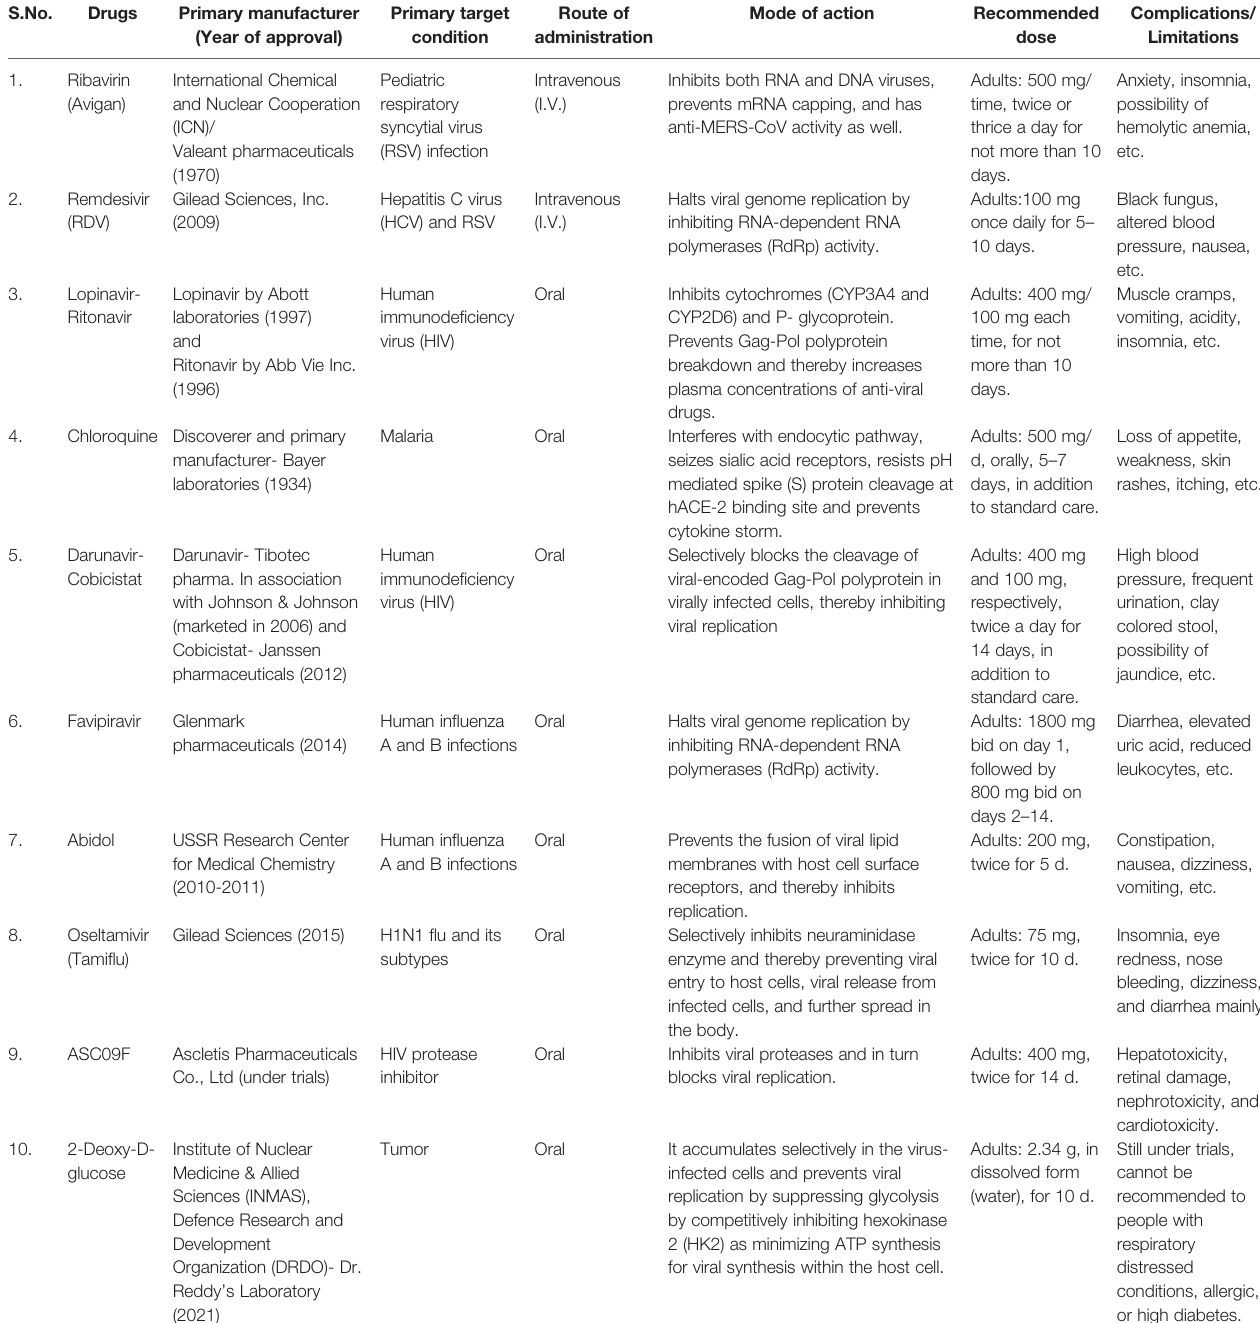
TABLE 1 | The list of potential therapeutics against clinical manifestations of COVID-19 in use and their side effects.